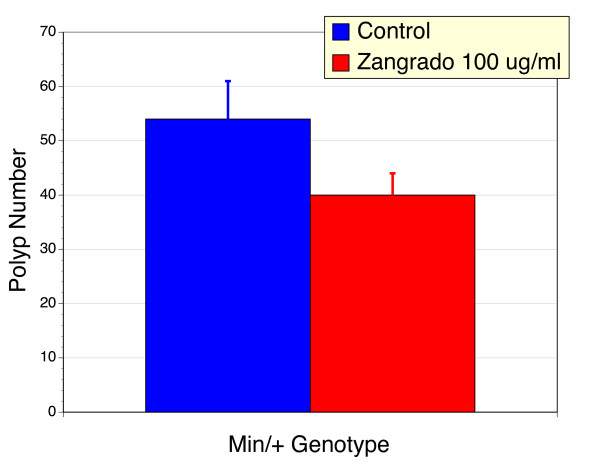
Polyp number in control or Zangrado treated ApcMin/+mice. ApcMin/+mice treatment with Zangrado (100 μg/ml in drinking water, n = 5) displayed a 26% reduction in the number of polyps when compared to vehicle control mice (n = 10). This trend was not statistically significant. There were no polyps noted in wild type mice.